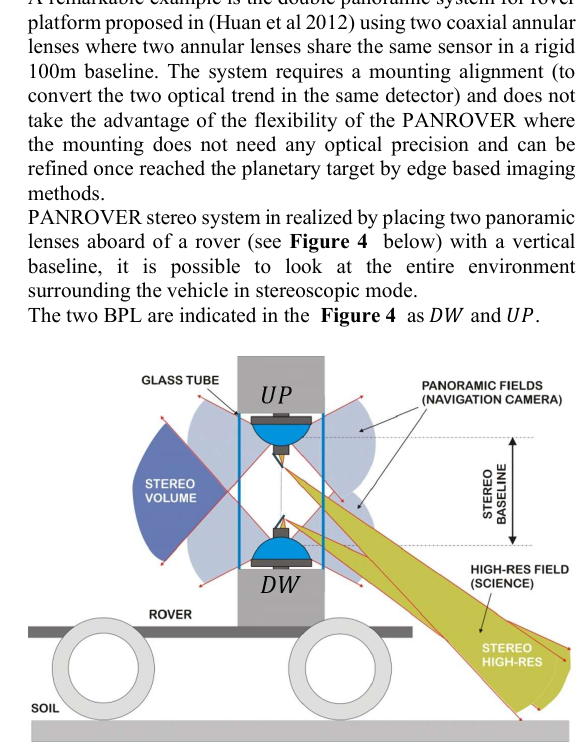
Table 1 Main parameters of the known Mars panoramic systems, for comparison. The instruments are part of the payloads